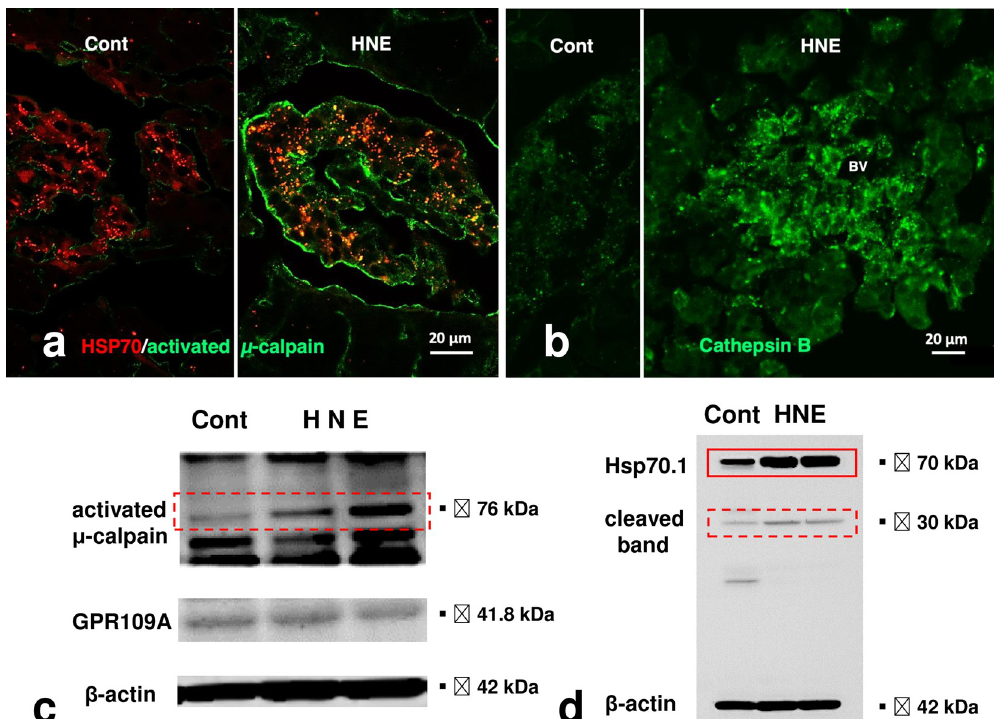
Fig 7. Calpain activation, Hsp70.1 cleavage, and cathepsin B leakage. a) Immunofluorescence histochemical staining of Hsp70.1 (red) and activated μ -calpain (green). Activated μ -calpain immunoreactivity is negligible without hydroxynonenal injections (Cont), whereas μ -calpain activation occurs with hydroxynonenal injections (HNE), being consistent with the Western blotting data (c, activated μ -calpain). After hydroxynonenal injections, activated μ -calpain immunoreactivity (green) is colocalized with Hsp70.1 immunoreactivity (red), showing a merged color of yellow (HNE, yellow). The distribution pattern of granular merged colors is compatible with that of autolysosomes as seen in Fig 2. b) Immunofluorescence histochemical staining of cathepsin B (green). Cathepsin B is stained as tiny granules in the control Langerhans islet (Cont), whereas stained as coarse granules with the perigranular immunoreactivity after hydroxynonenal injections (HNE), which indicates lysosomal membrane rupture/permeabilization. The nuclei show negligible cathepsin B immunoreactivity. Cathepsin B immunoreactivity was colocalized with that of Lamp2 (data not shown here). c, d) Western blotting analyses of activated μ -calpain (c, 76 kDa), GPR109A (c, 41.8 kDa), and Hsp70.1 (d, 70 kDa). Compared to the control (c, Cont), μ -calpain is activated after hydroxynonenal injections (c, HNE). In response to the cell stress due to hydroxynonenal injections (d, HNE), not only Hsp70.1 main bands (d, rectangle) but also cleaved Hsp70.1 bands of 30 kDa (d, dot rectangle) are increased, compared to the control (d, Cont). GPR109A is expressed in the pancreas tissue, although showing no change after hydroxynonenal injections (c,